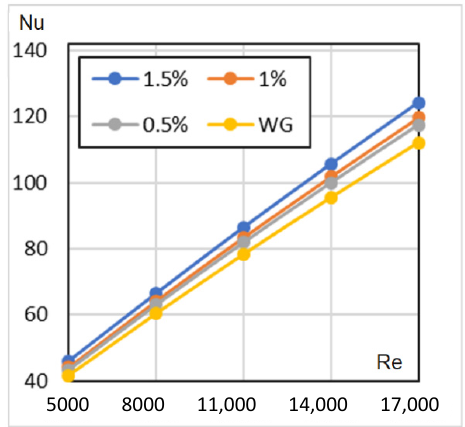
Figure 9. Nusselt numbers against Reynolds numbers for constant HF.